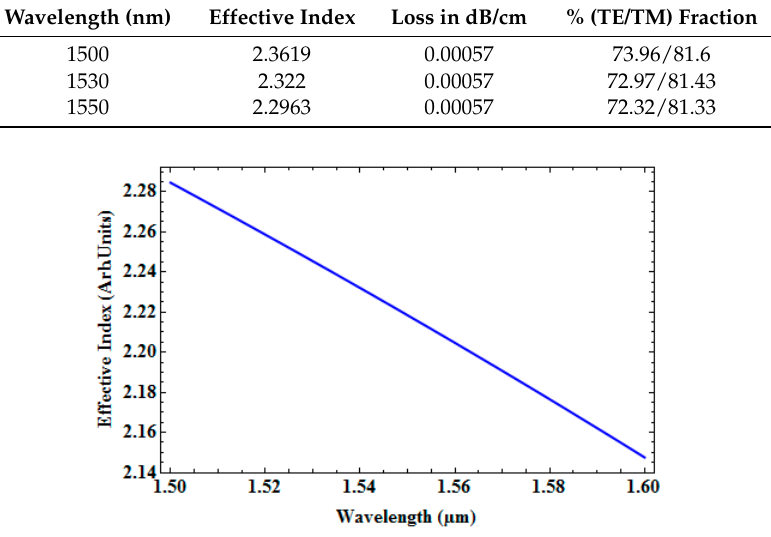
Figure 9. Effective index as a function of wavelength.